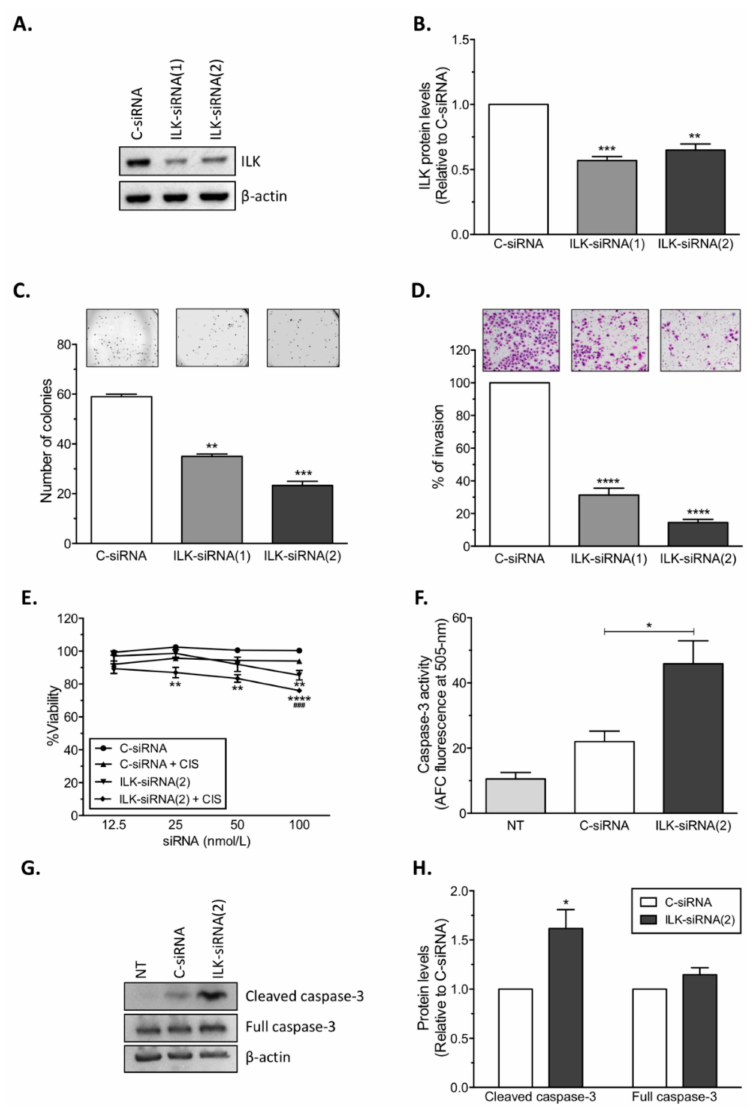
Figure 2. SiRNA-mediated ILK targeting in A2780CP20 cells. SiRNAs were transiently transfected into ovarian cancer cells. A reduction in ( A , B ) ILK protein levels, ( C ) colony formation, ( D ) invasion ability, and ( E ) cell viability was observed following ILK-siRNA transfection into A2780CP20 cells. Attached and floating cells were collected 72 h after transfection. ( F ) Protein extracts from siRNA-transfected cells were used to assess caspase-3 activity (DEVD-AFC cleavage). Increased caspase-3 activity was observed upon ILK-siRNA transfection. ( G ) Representative Western blot showing full caspase-3 and its cleavage product. ( H ) Densitometric analysis of the band intensities shown in Figure 2G. Mean ± SEM is shown relative to C-siRNA (* p < 0.05, ** p < 0.01, *** p < 0.001, and **** p < 0.0001) or C-siRNA + CIS (### p <